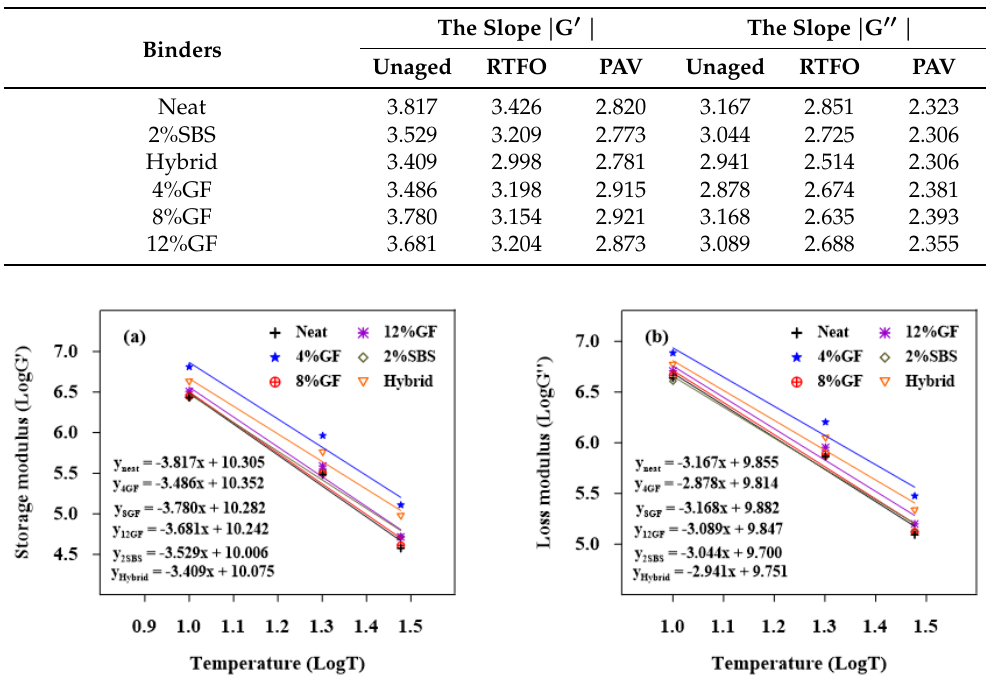
Figure 4. Sensitivity of unaged binders to temperature for ( a ) G (cid:48) and ( b ) G (cid:48)(cid:48) .